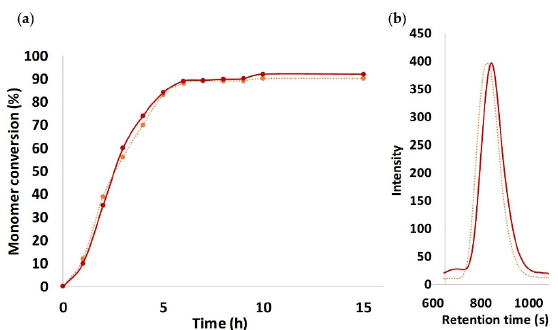
Figure 4. Comparison of ( a ) kinetic profile of PTMC initiated by 1,6-hexanediamine using Sn(Oct) 2 (line red) 1,6-hexanediol (dots orange), and ( b ) SEC traces of the resulting polymers.